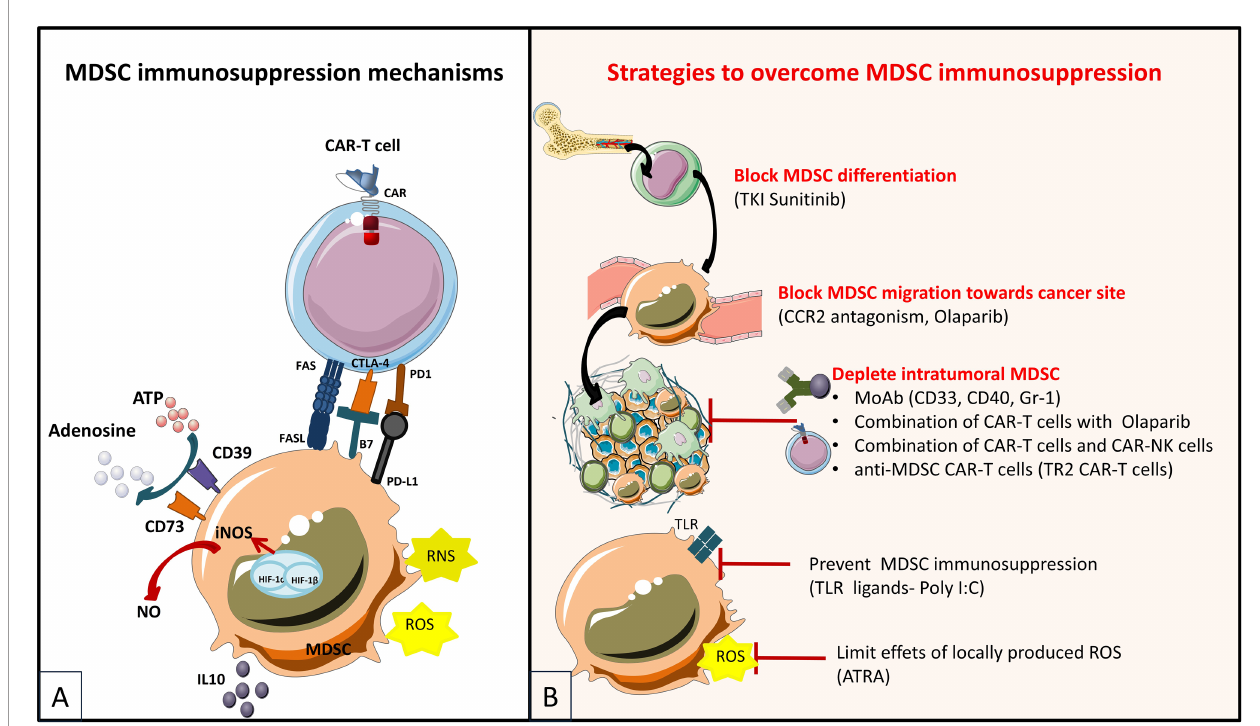
FIGURE 6 | Immunosuppressive mechanisms exerted by MDSCs in the tumor microenvironment (A) and engineering strategies to surmount MDSC-induced immunosuppression (B) [Adapted from Krishnamoorthy et al. (250)]. (A) MDSC exert immunosuppressive effects in the TME (tumor microenvironment) by secretion of IL10 (which activates other immunosuppressive cells such as Tregs). Moreover, MSDCs can induce upregulation of checkpoint molecules (CTLA4, PD1) on T- cells, further inducing T-cell anergy, or can upregulate Fas which induces T-cell apoptosis by contact Fas/Fas-L mechanism. As an effect of hypoxia in the TME, MDSC can contribute to adenosine production by upregulation of CD73 and CD39. MDSCs also produce reactive oxygen (ROS) and nitrogen (RNS) species that can decrease T-cell proliferation and alter antigen recognition capabilities. (B) Strategies for targeting MDSCs in cancer are for example the prevention of MDSC differentiation from hematopoietic stem cells by the usage of Sunitinib, a tyrosine kinase inhibitor (TKI) that inhibits crucial factors for MDSC differentiation (VEGF and STAT3 activity). Second type of strategy is to prevent MDCS migrating to the tumor by targeting chemokine/chemokine receptor axes (CCR2/CCL2). Third, MDSCs depletion from the tumor can be achieved by using immunotherapy (depleting antibodies targeting CD33/gemtuzumab ozogamicin (GO), CD40 or Gr1) or chemotherapy. And least, mitigating the immunosuppressive effects of MDSCs at the tumor site can be realized by reducing the local effects of ROS (with ATRA or all-trans-retinoic acid) or by using TLR stimulation with speci fi c ligands (TLR3 ligand polyinosinic-polycytidylic acid Poly